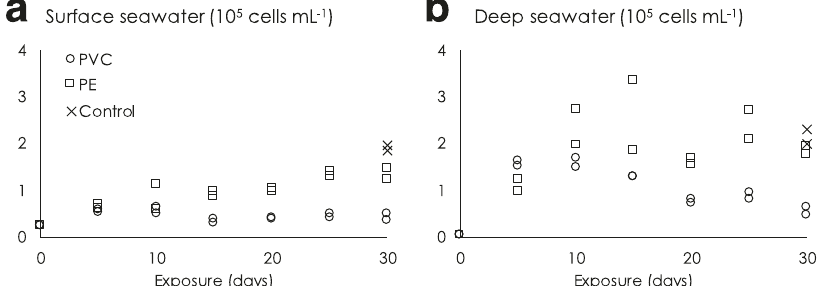
Fig. 2 Prokaryotic content in seawater. Changes in prokaryotic abundance (10 5 cells mL − 1 ) over time in the presence of polyethylene (PE, squares) and polyvinylchloride (PVC, circles) pellets under surface ( a ) and deep seawater conditions ( b ). Controls are seawater incubated with no polymer for 30 days under biotic conditions (crosses).